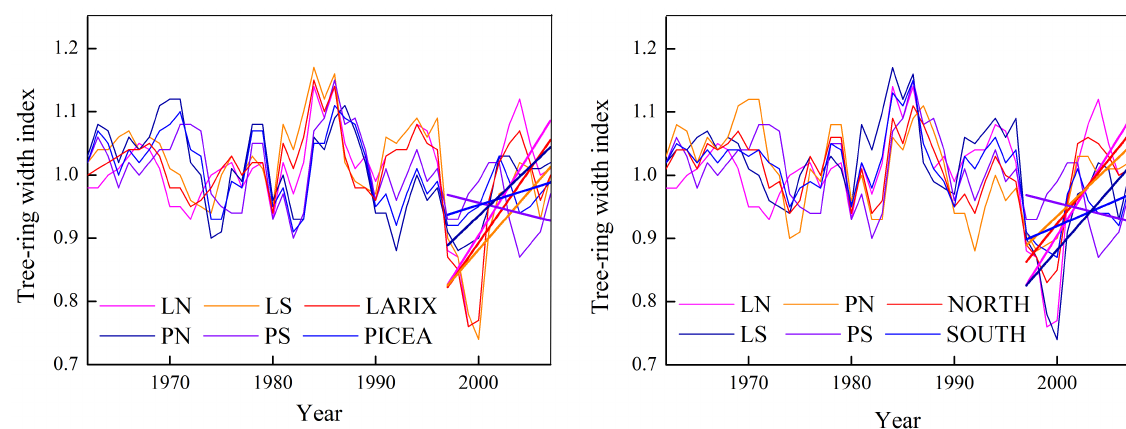
Figure 6. Trends of the eight chronologies using a three-year